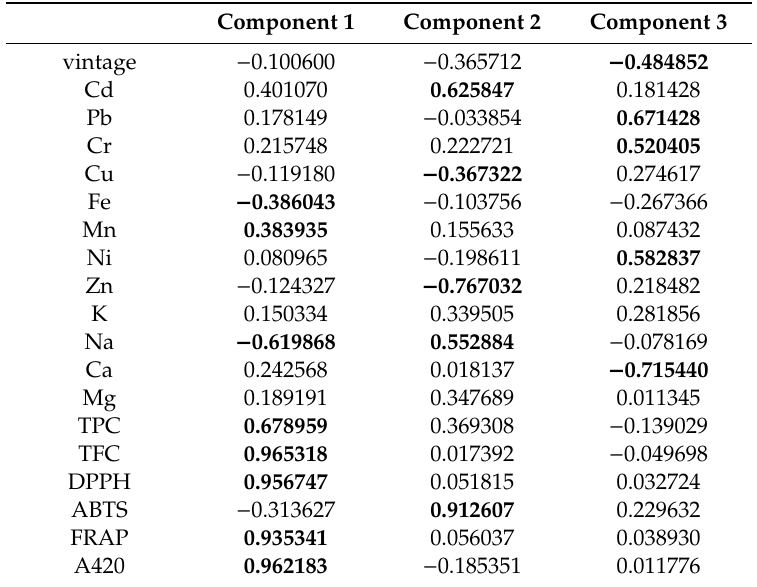
Table 5. Rotated factor